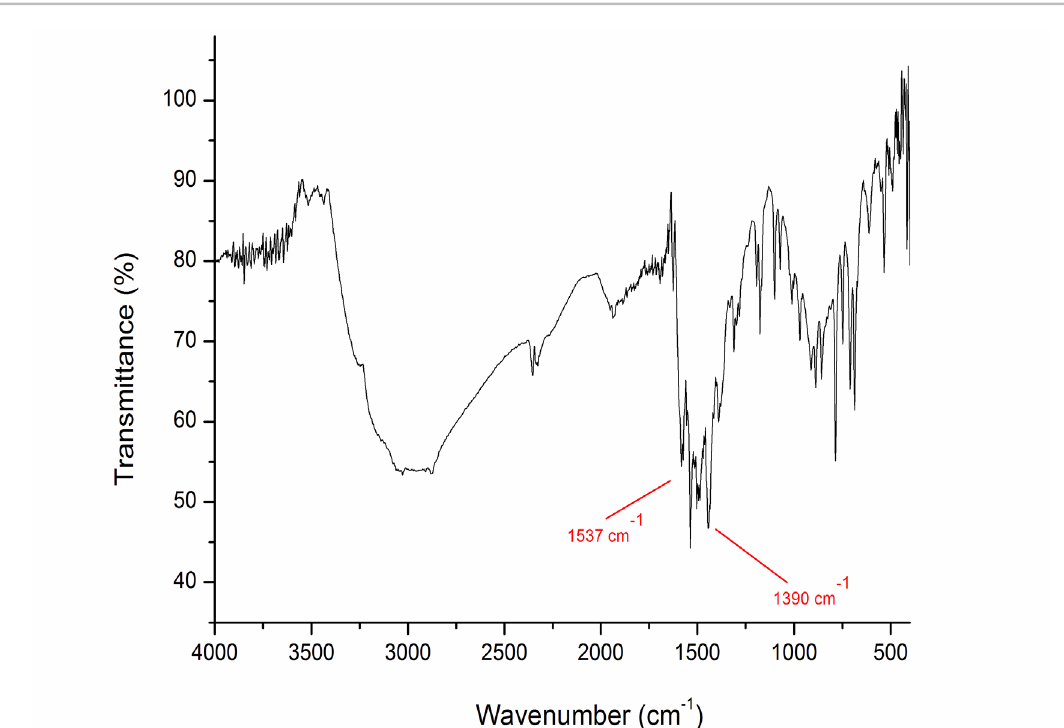
FIGURE 5 – FT-IR spectrum of catena -poly-{[trans(diaqua- kO )cobalt(II)]-bis( m - p -(benzylideneamino)benzoato- k²O,O’) }.